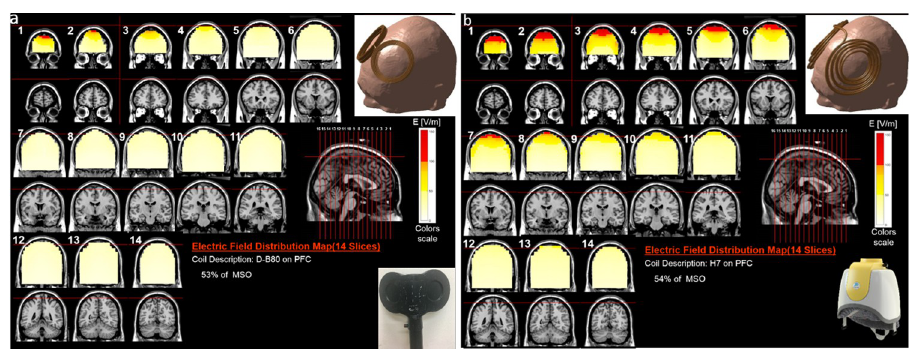
Fig 1. Colored maps of electric field distribution. Colored field maps for the D–B80 (a) and for the H7 (b) showing electric field distribution within the brain, when located at the treatment location over the prefrontal cortex, indicating the electric field absolute magnitude in each pixel over 14 coronal slices 1 cm apart. The maps were adjusted to the average percentage of the maximal stimulator output required to achieve 100% of the leg rMT, which are 53% for the D–B80 and 54% for the H7. The red pixels indicate field magnitude � the threshold for neuronal activation, which was set to 100 V/m.